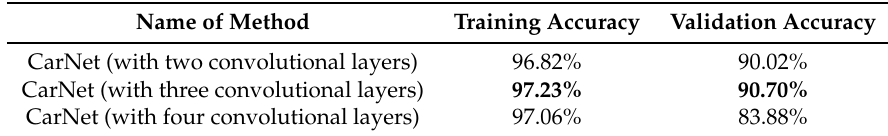
Table 5. Comparisons of training and validation accuracies for CarNet (with two layers), CarNet (with three layers) and CarNet (with four layers).